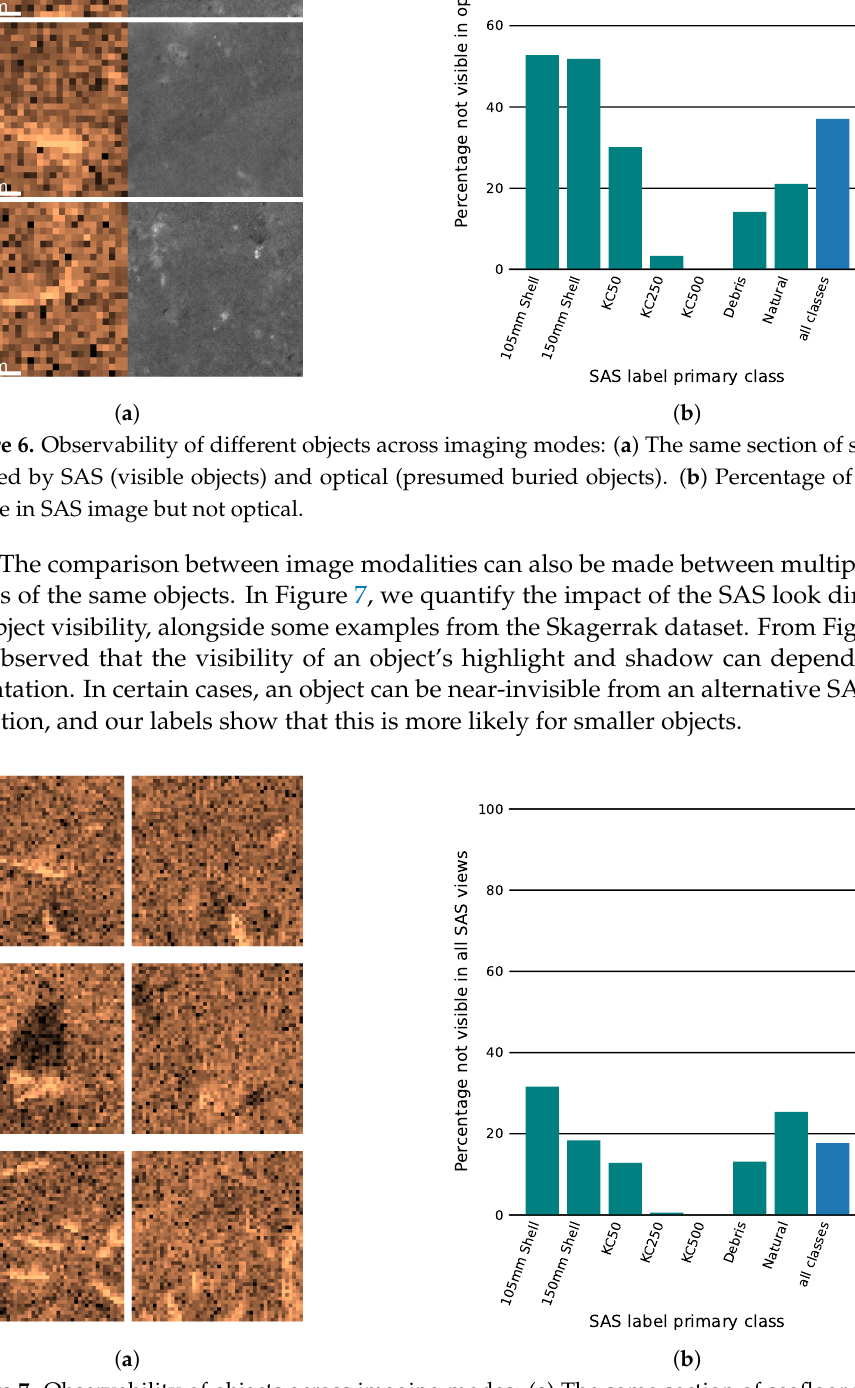
Figure 7. Observability of objects across imaging modes: ( a ) The same section of seafloor viewed from perpendicular SAS look directions. ( b ) Percentage of objects not visible in all SAS look directions (typically